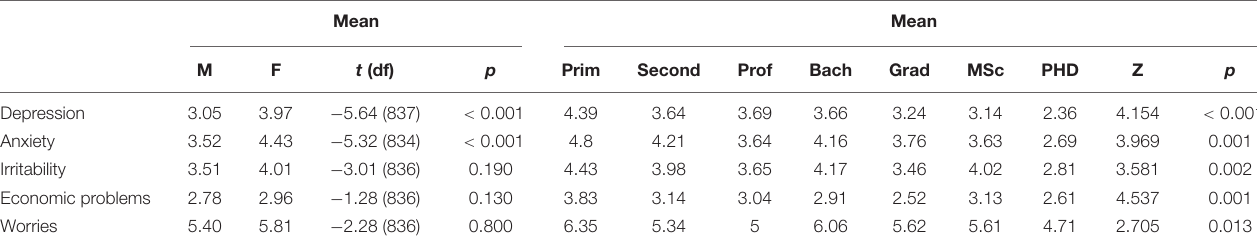
TABLE 4 | Gender/Education level comparisons and psychosocial factors in the elderly. Mean Mean M F t (df) p Prim Second Prof Bach Grad MSc